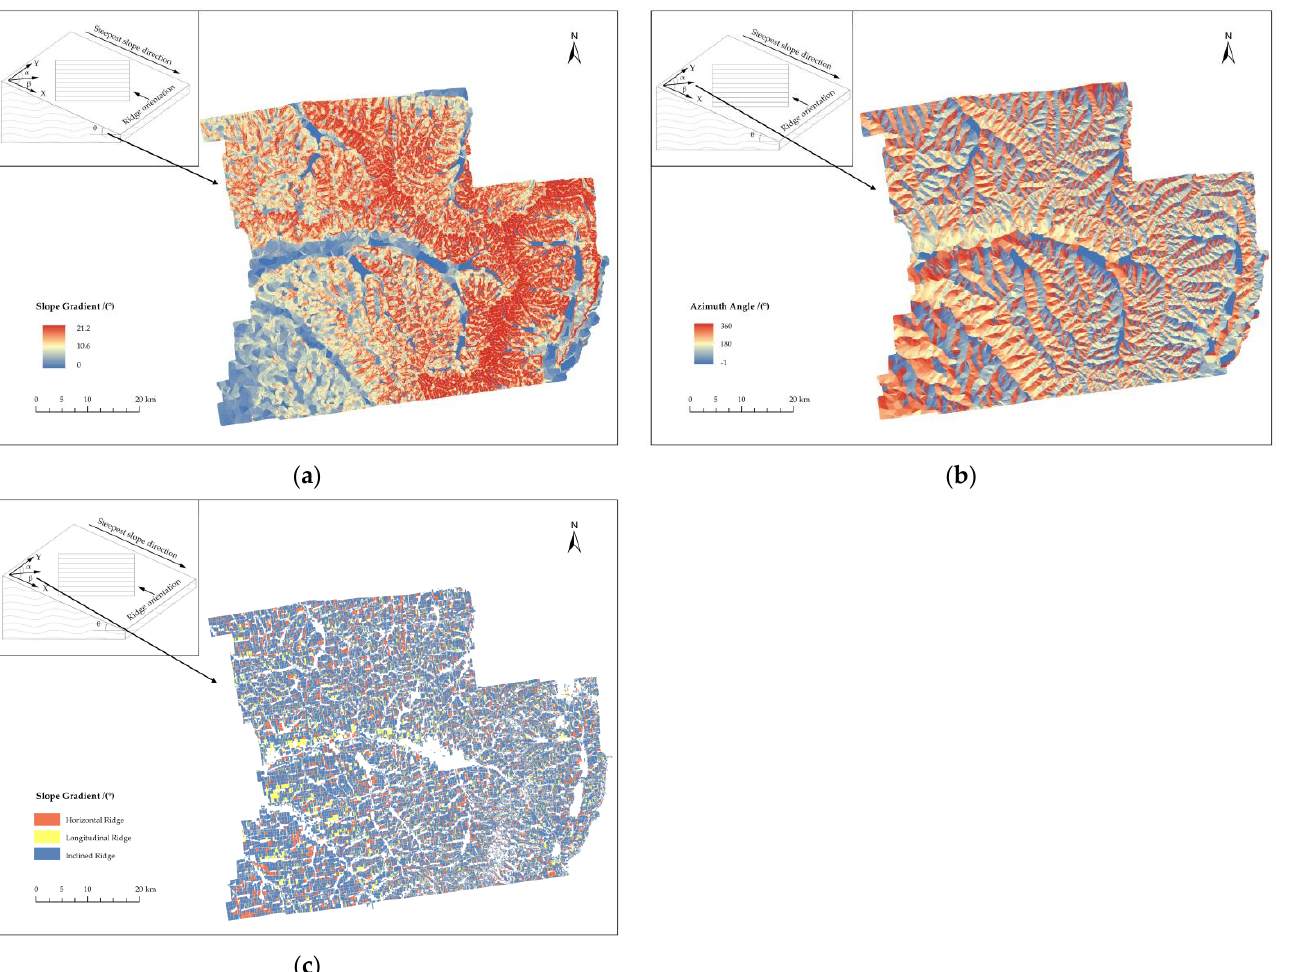
Figure 3. Maps showing ( a ) slope gradient, ( b ) slope aspect and ( c ) ridge orientation. In ( c ), red rep- resents horizontal ridges, yellow represents longitudinal ridges and blue represents inclined